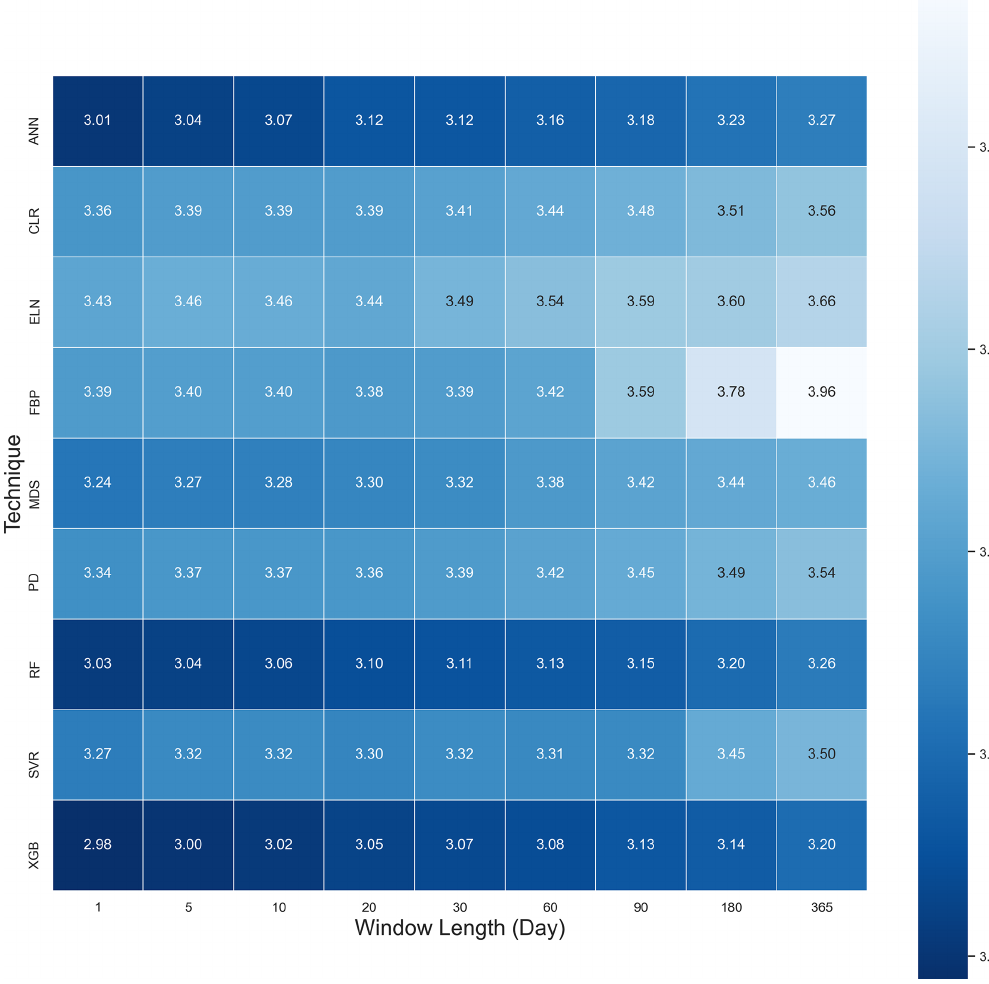
Figure 1. A heat map of mean RMSE values of F c across all sites based on nine algorithms and nine window lengths in